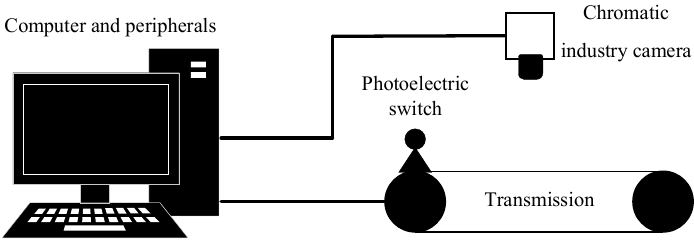
Figure 2. Structural diagram of the particleboard surface defect detection system.